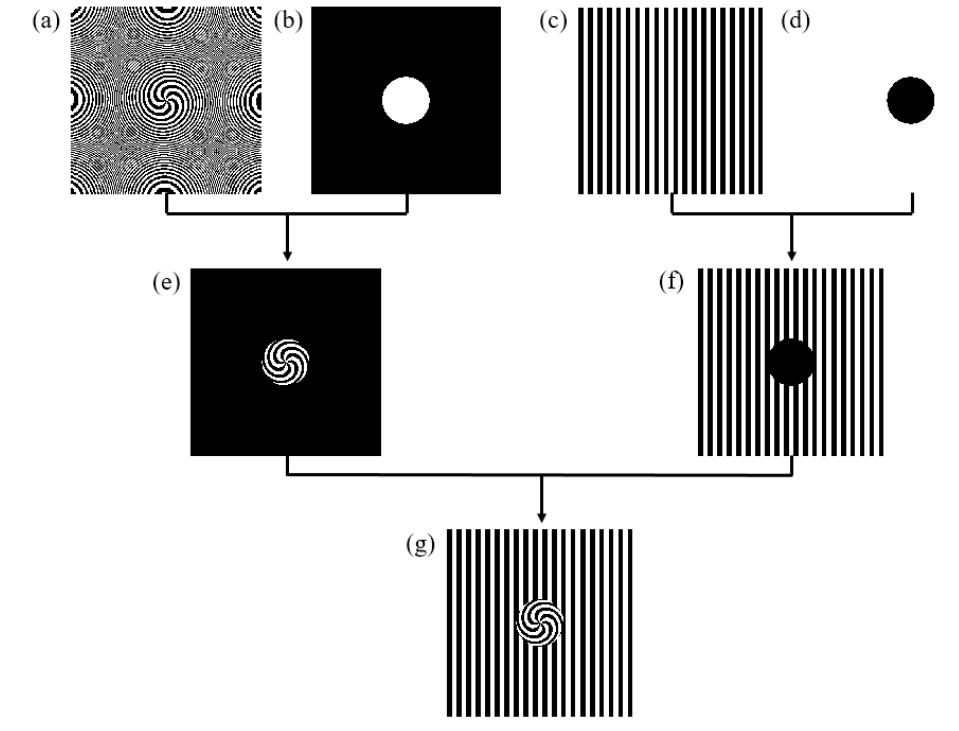
Figure 1. The construction method of the CSZPG; the schematic diagrams of ( a ) the SZP , ( b ) the filter, ( c ) the grating, ( d ) the inversed filter, ( e ) the inner spiral zone plate, ( f ) the outer grating, and ( g ) the CSZPG , respectively.